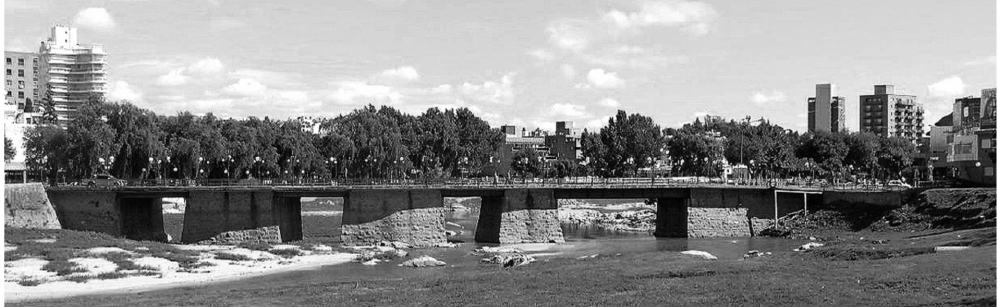
Figure 2. The existing 1889 bridge, its supporting piles account for 45% of the drainage section. (Credit: Reproduced with permission from the author, Eng. Ger ó nimo C á ffaro).